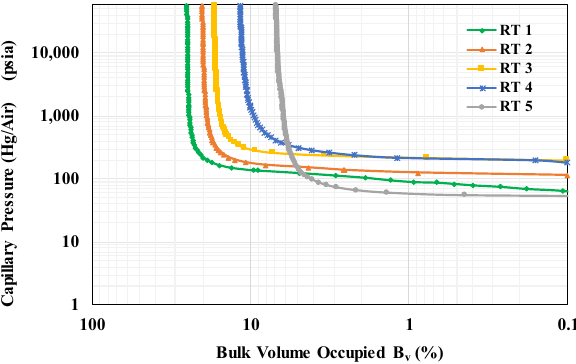
Fig. 7 Plot of variance between water saturation S and S w log data and numbers of rock types